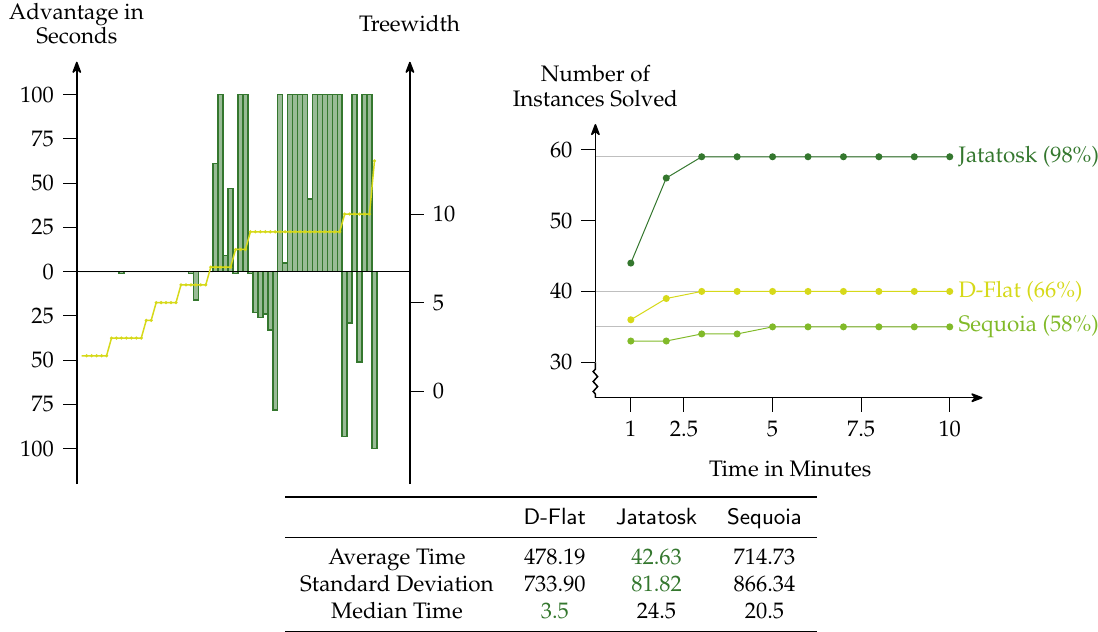
Figure 2. Experiment for the 3- COLORING problem.